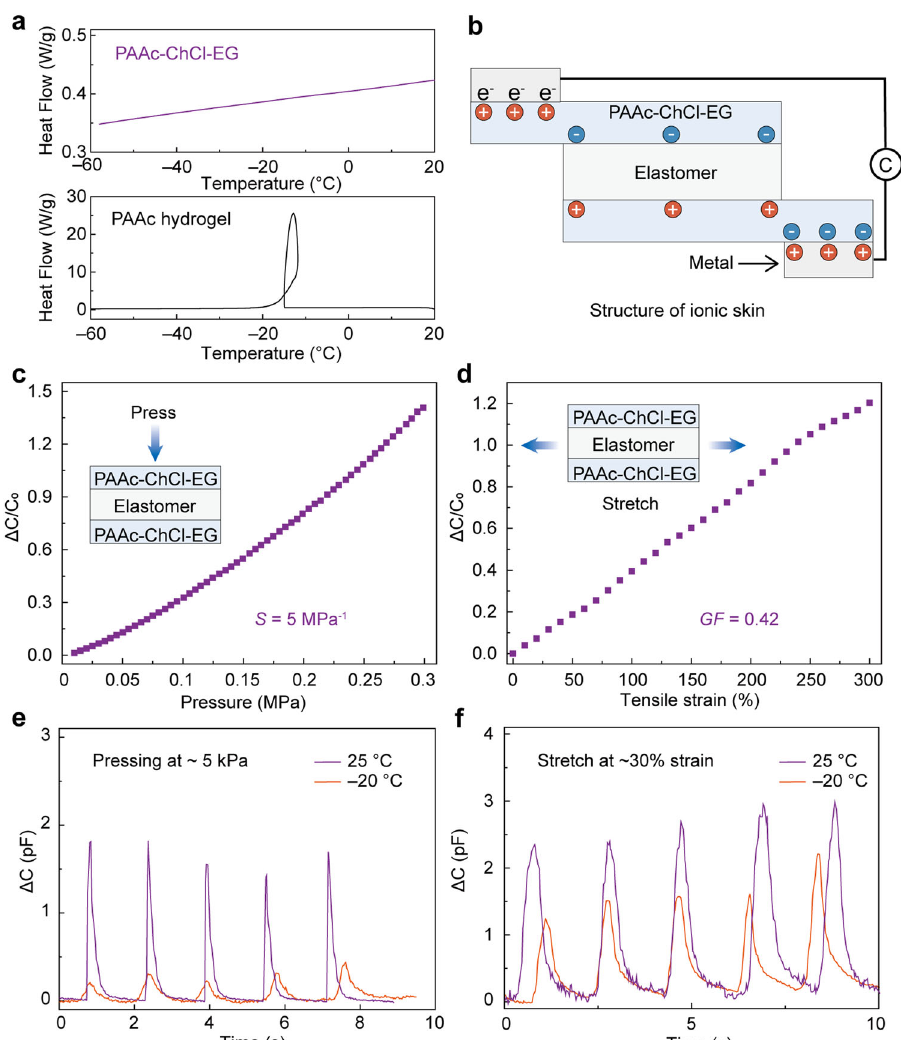
Fig. 4 PAAc – DES gel-based ionic skin for low-temperature applications. a Differential scanning calorimetry (DSC) curves of the PAAc – ChCl – EG gel and the PAAc hydrogel that are cooling from 20 to – 60 °C. b Illustration of the device structure. c Response of the ionic skin as a function of applied pressure. d Response of the ionic skin to different tensile strains. e Signal generated by fi nger touching at room temperature and – 20 °C, respectively. f Signal generated by stretching at room temperature and – 20 °C,